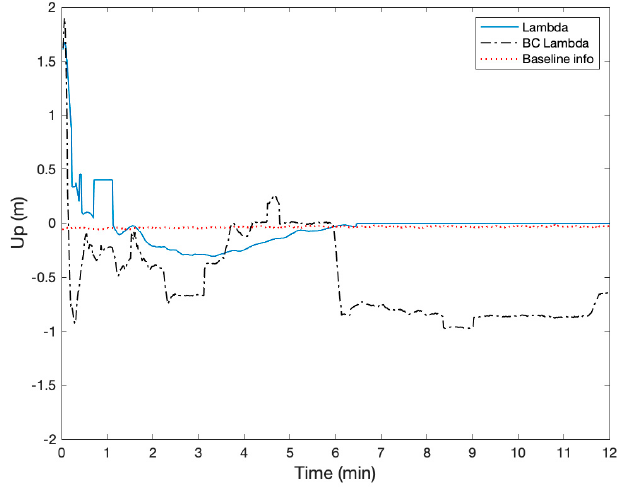
Figure 15. Comparison of the positioning error in the Up using LAMBDA, Baseline Constrained (BC) LAMBDA, and the proposed method using baseline information.